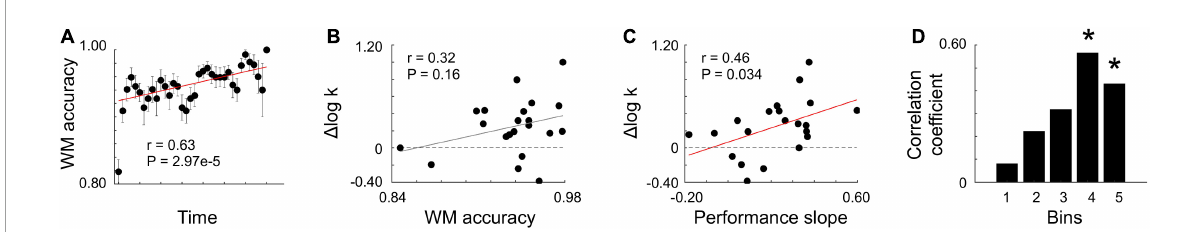
FIGURE3 Individual performance enhancement in working memory training is associated with level of impulsivity reduction (experiment 1). (A) Change over time in working memory task accuracy was measured to examine whether or not the individuals showed performance enhancement. Average accuracy within each 10-trial sliding window (with 5-trial overlap) was calculated per participant. Indeed, the participants showed a significant performance improvement over time (Pearson’s correlation r = 0.64, P = 2.97e-5). Each dot represents mean accuracy within each window across participants, and error bars indicate s.e.m. (B) Although statistically not significant, individuals’ overall performance (i.e., accuracy) in the working memory task had a trend of positive correlation with the changes in their delay discounting rates ( r = 0.32, P = 0.16, bootstrapping P = 0.16). Specifically, individuals who had the highest (lowest) accuracy in the working memory task showed a relatively larger (smaller) reduction in their estimated impulsivity (positive (cid:49) log k indicates one’s impulsivity reduction). (C) Independent of individuals’ initial accuracy level, individuals’ speed of working memory performance enhancement (performance slope) was significantly correlated with level of impulsivity reduction ( r = 0.46, P = 0.036, bootstrapping P = 0.034). Each dot represents an individual, and solid red lines are robust regression lines. (D) By dividing the working memory task into five bins (bin size = 1/3 of the entire task length, sliding window with 1/6 overlap), a stark difference was observed between bins in the association between individuals’ working memory accuracy and their impulsivity reduction levels. Particularly, individuals’ working memory task performance in the later period (fourth and fifth bins) showed strong associations with the extent to which they make less impulsive choices in the post-intervention ITC task. * P <